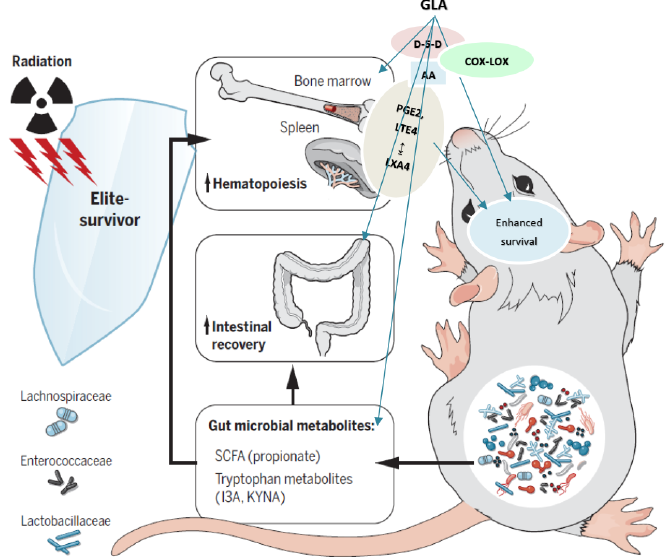
Figure 18. Scheme showing potential mechanisms involved in the beneficial actions of GLA and its products (PGE2/LTE4/LXA4 derived from AA and AA, in turn, is derived from GLA by the action of delta-5-desaturase). In summary, the results of the present study suggest that GLA is a radioprotective agent that needs to be explored and exploited for use in future human studies.